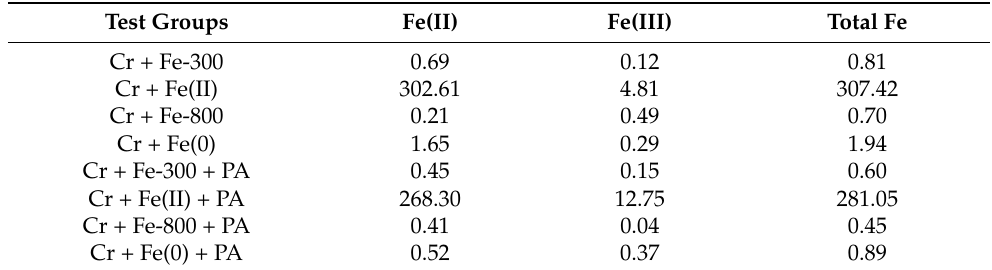
Table 2. The iron concentrations of experimental groups after incubation for 30 min